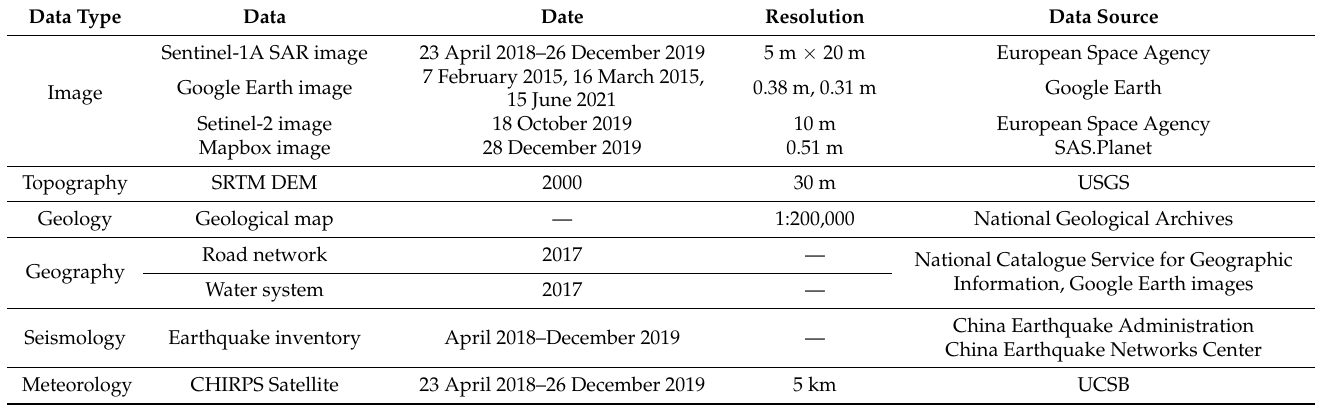
Table 1. Multisource data adopted in this work. The abbreviations include: USGS = United States Geological Survey; CHIRPS = Climate Hazards Group infraRed Precipitation with Station data; SRTM = Shuttle Radar Topography Mission; and UCSB = University of California Santa